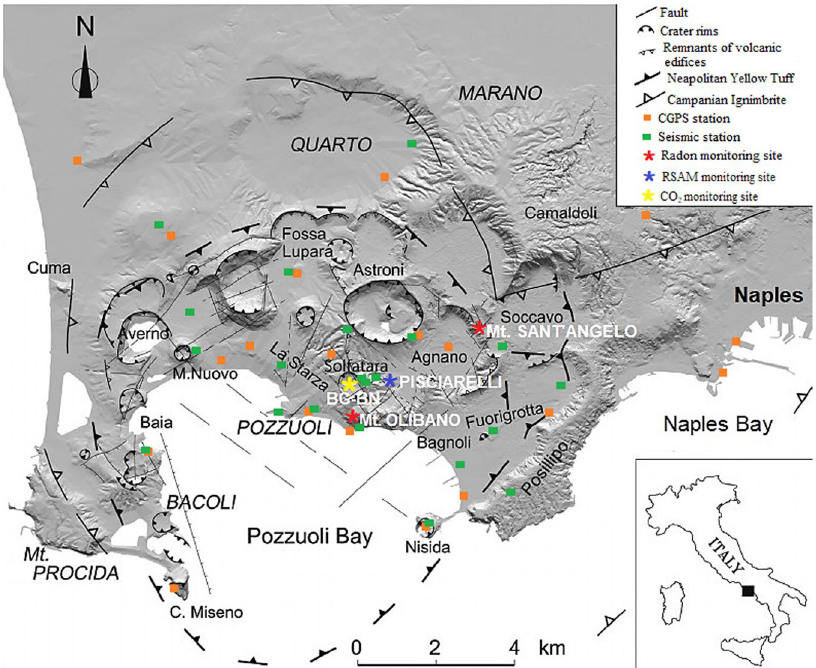
Figure 1. Map of the Campi Flegrei caldera (Naples-Italy). The map, modified after 16 (10.1016/j. apradiso.2020.109140) using the PAINT (Microsoft Corporation, Version: 6.1907.18017.0), shows the structural setting of the caldera characterised by tectonics and volcano-tectonic activity. The two radon monitoring sites of Monte Olibano and Monte Sant’Angelo, and the others monitoring sites of geochemical and geophysical parameters are reported. The squares represent the Campi Flegrei seismic network in green and the NeVoCGPS network in orange (see